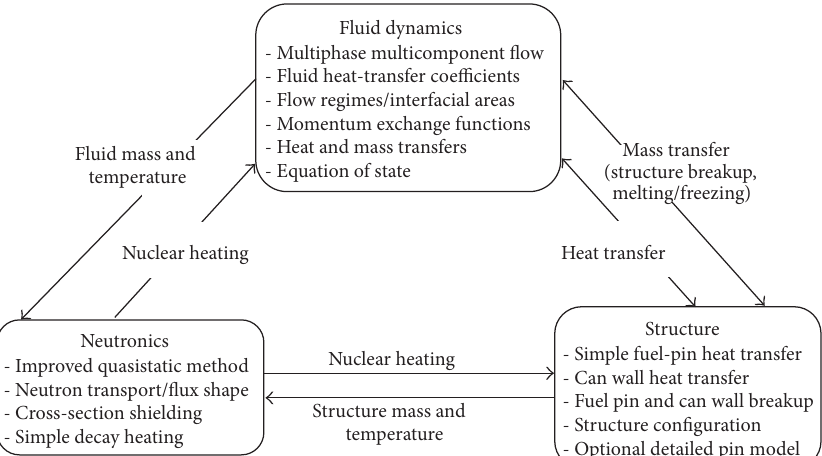
Figure 2: SIMMER-III overall code